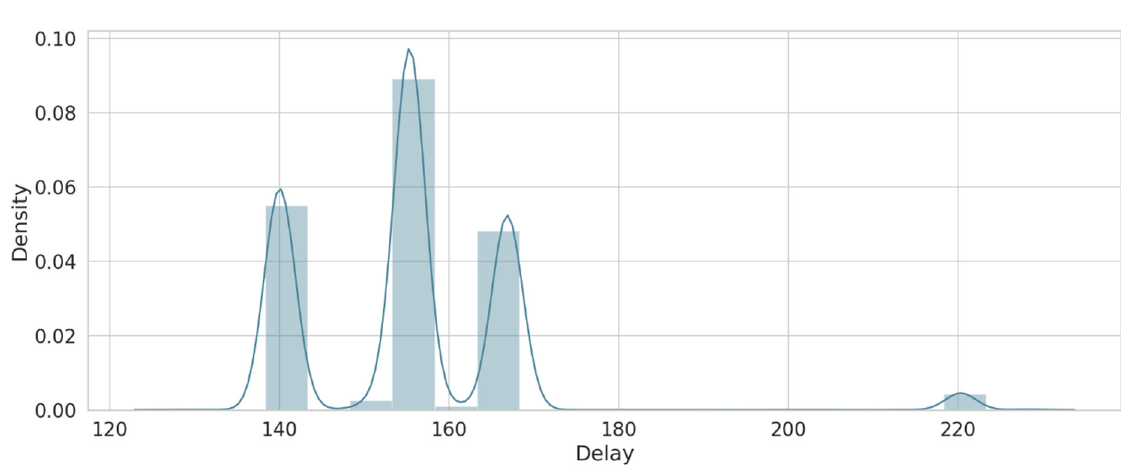
Figure 6. Delay sample.